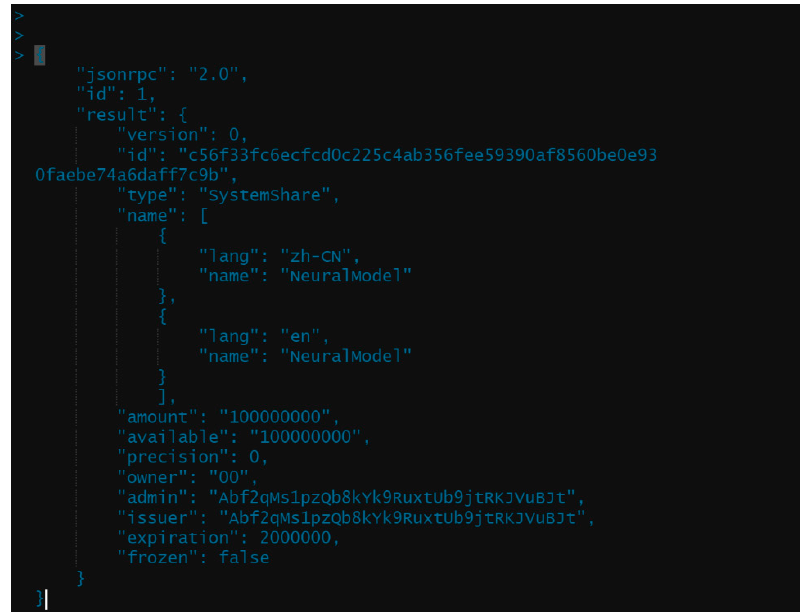
Figure 8. Verification source code for NeuralModel Asset_id.